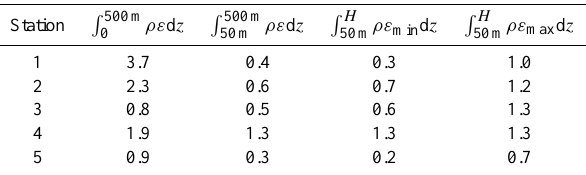
Table 3. Depth-integrated dissipation rate at observation stations in units of 10 − 3 × Wm − 2 . Integrations down to 500m are obtained from the station mean ε profiles. Integrations from 50m to the bot- tom use the assumed minimum and maximum ε profiles described in the text.